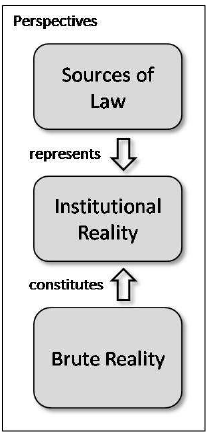
Figure 1: Layers of reality and